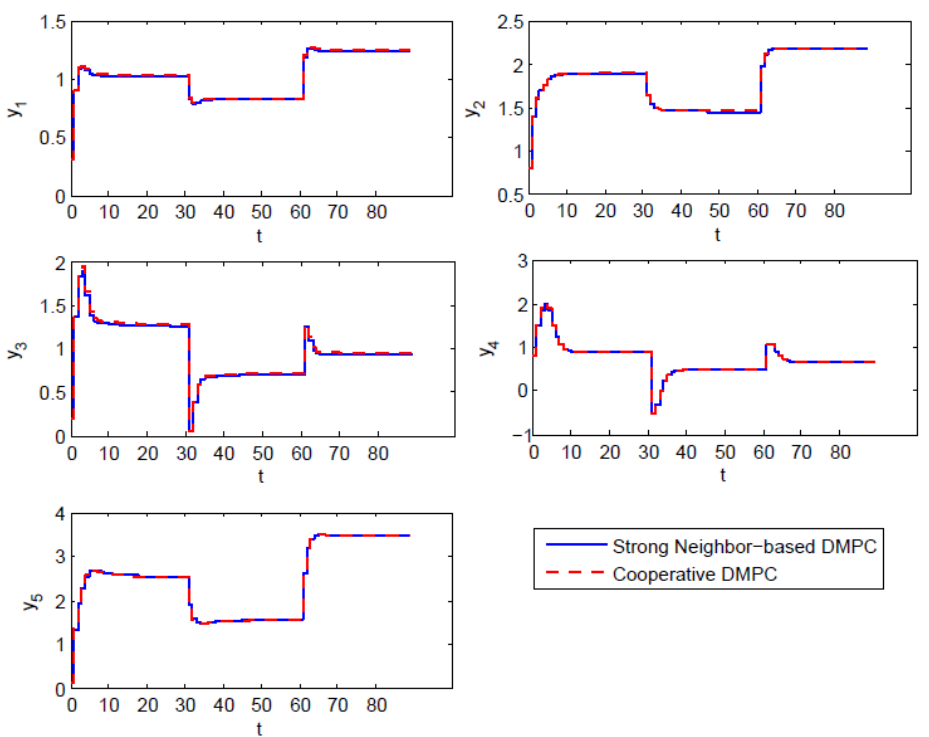
Figure 4. Output of each subsystem under the control of SCN-DMPC and cooperative DMPC.